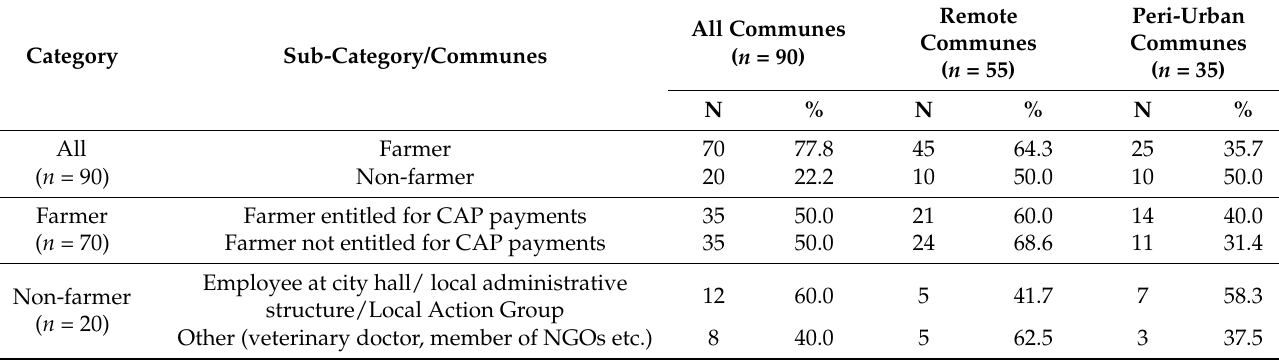
Table 2. Category of